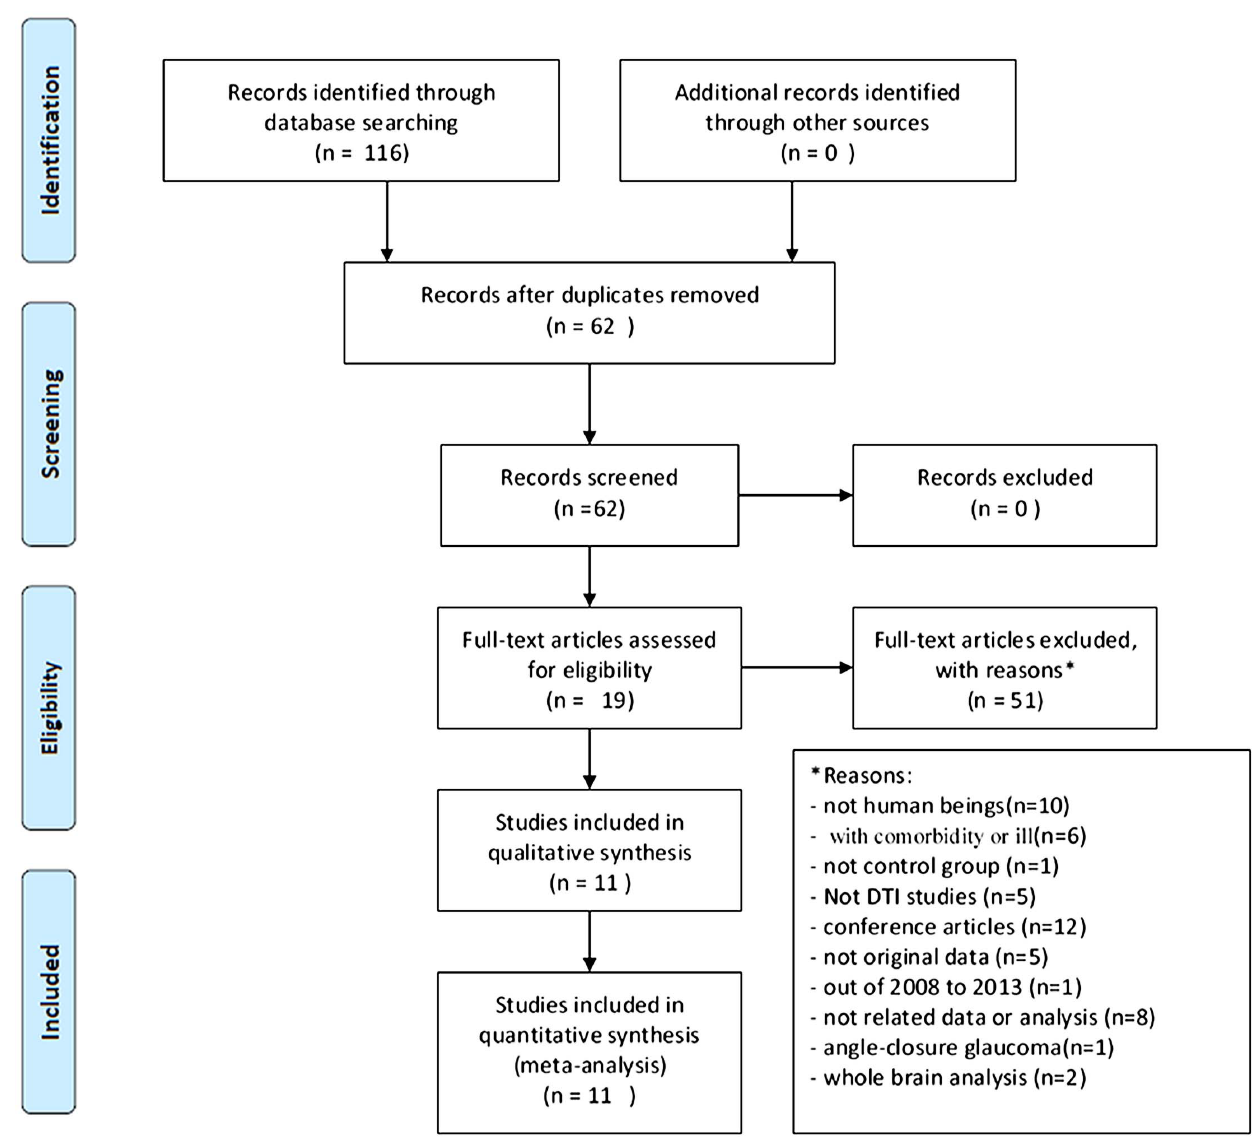
Figure 1. Process of study selection.